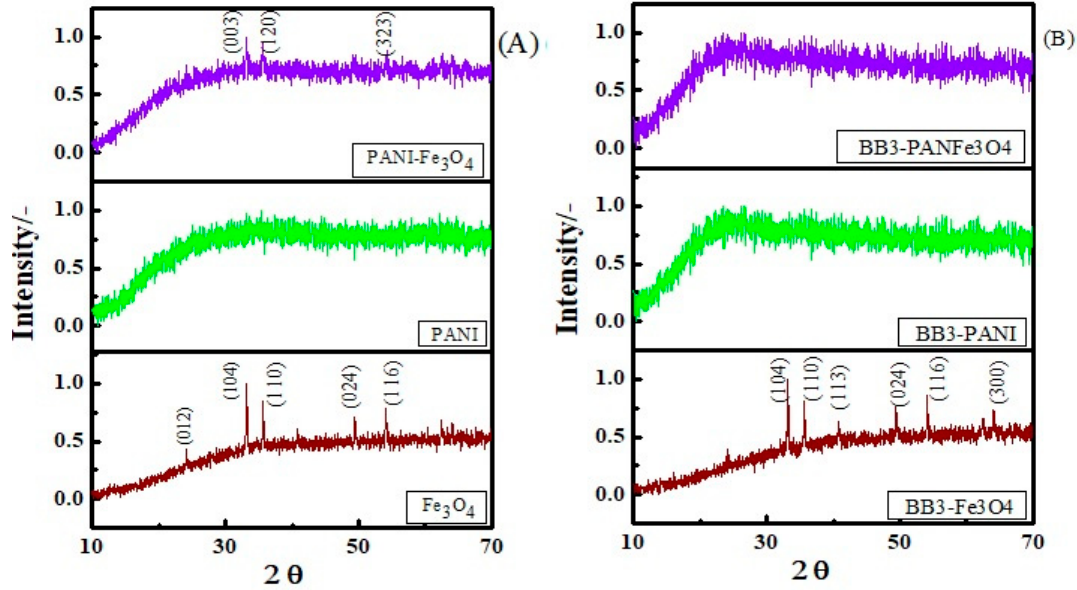
Figure 5. XRD of Fe 3 O 4 , PANI, and PANI / Fe 3 O 4 ( A ) before and ( B ) after adsorption of BB3.